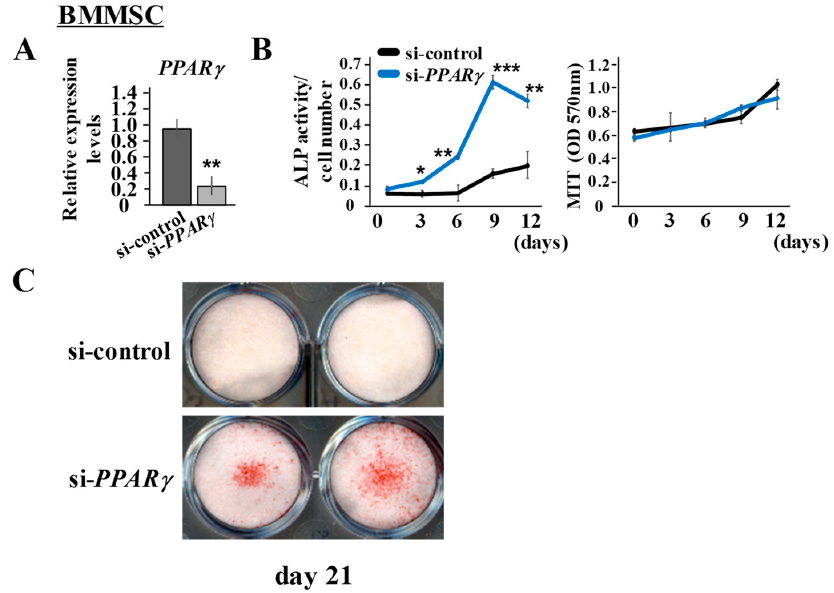
Figure A2. PPAR γ agonists are unable to induce ALP activities in PDLF transfected with si- PPAR γ . ( A – C ) BMMSC were transfected with si-control or si- PPAR γ . ( A ) PPAR γ mRNA expression 24 h after transfection was analyzed using HPRT for normalization. ( B ) ALP activities were measured and cell numbers were enumerated by MTT every 3 days. ALP activities are normalized with MTT values. ( C ) Alizarin red S staining was performed on day 21. Data represent the mean ± SD of three independent experiments. * p < 0.05; ** p < 0.01; *** p < 0.001 significantly higher than in cells transfected with si-control. Table A1. Primer pairs used in this study.